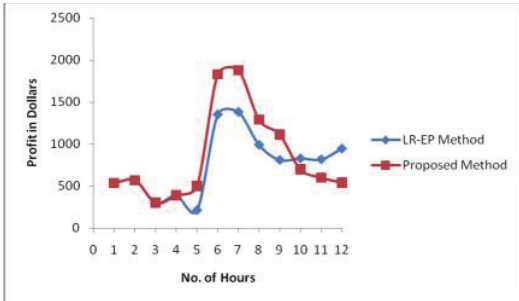
Fig 3. Comparison of Profit between LR-EP & Proposed Method A